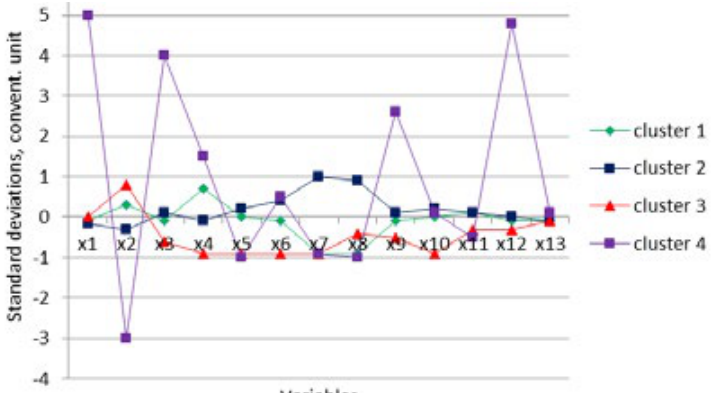
Fig. 3: Diagram of average values of indicators for the prevalence rates and susceptibility level of population to COVID-19 in rural areas of Sumy region